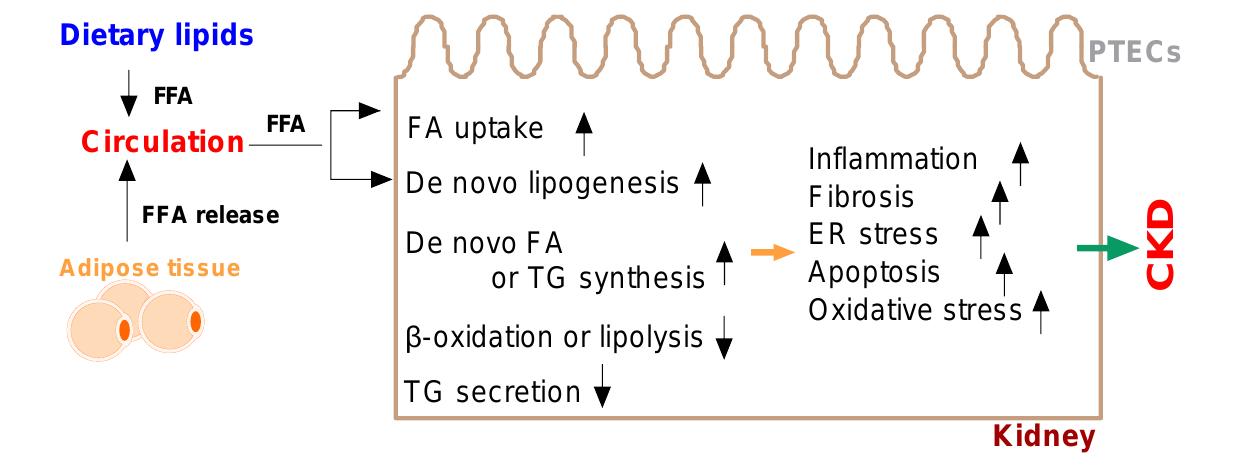
Figure 2. High free fatty acids (FFA) in circulation, originating from dietary lipids and adipose tissue, cause fatty acid metabolism disorders, thus acting as major risk factors for lipotoxicity and CKD in the kidneys. Increased fatty acid (FA) uptake increases de novo lipogenesis, increases de novo FA and TG synthesis, decreases β -oxidation or lipolysis and decreases triglyceride (TG) secretion, thus resulting in lipid accumulation in the PTECs of the kidneys. The lipotoxic effects caused by the ectopic accumulation of lipids in the kidneys include oxidative stress, fibrosis, endoplasmic reticulum (ER) stress, inflammation and other risk factors that cause lipotoxicity-induced CKD.